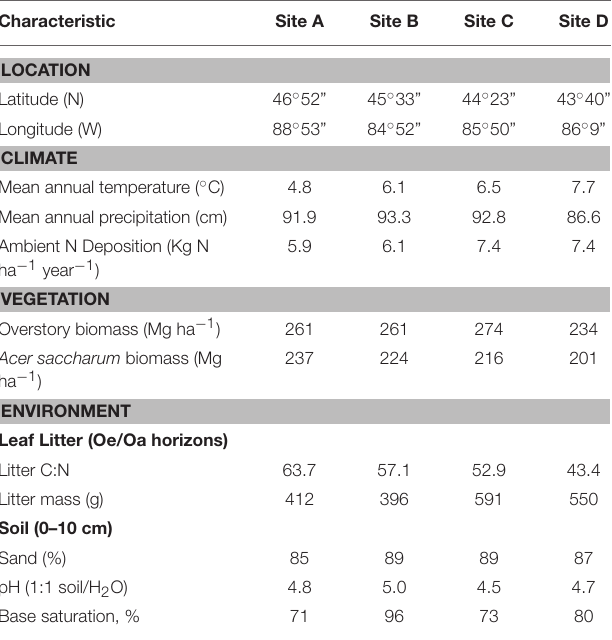
TABLE 1 | Site, climatic, overstory, and ambient nitrogen deposition rates of four study sites receiving experimental N